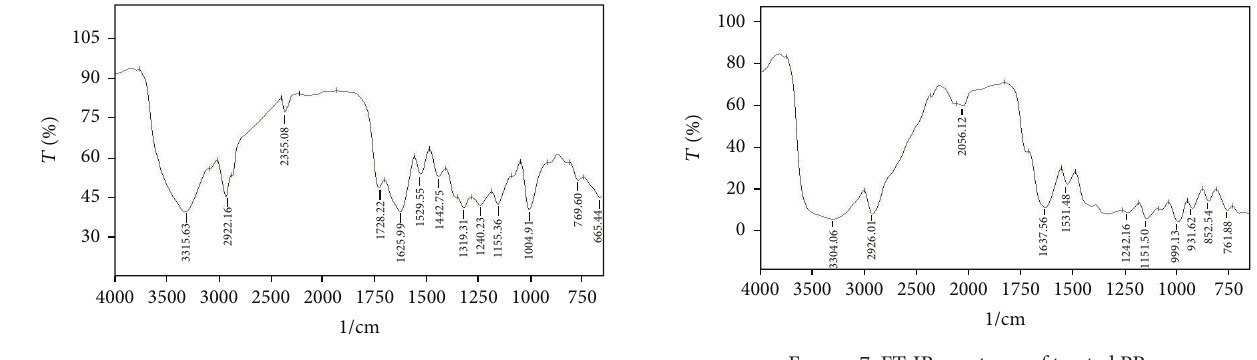
Figure 5: FT-IR spectrum of treated GL after adsorption of BG.